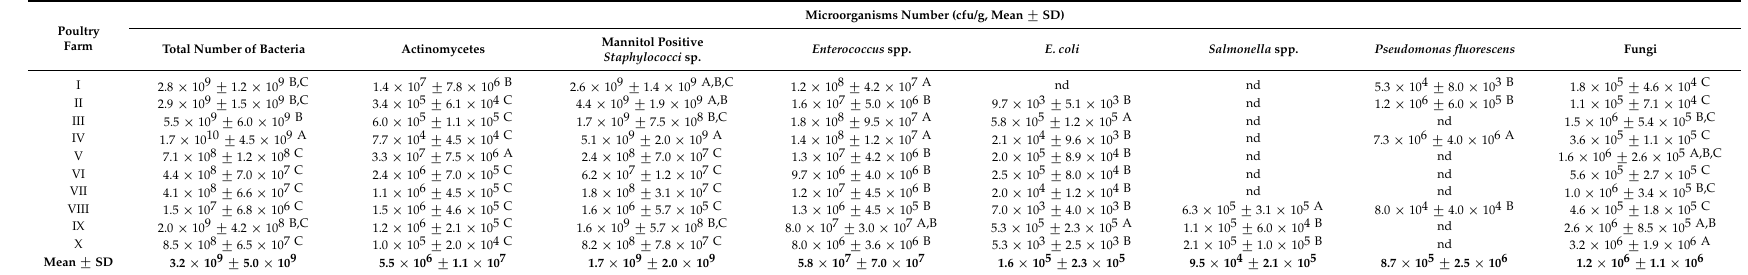
Table 6. Number of microorganisms in settled dust in poultry